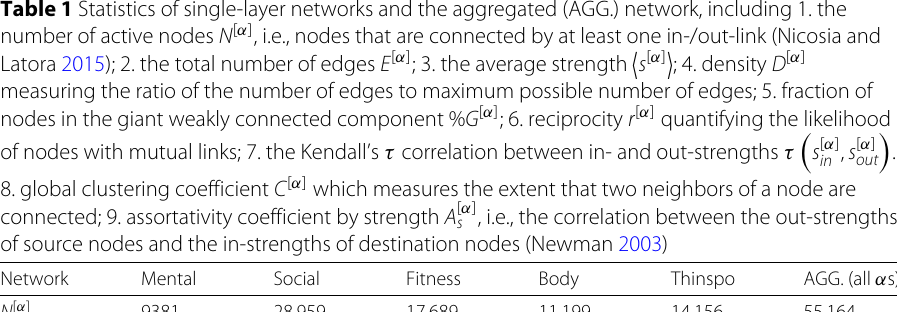
(cid:5) (cid:4) ; 4. density D [ α ] s [ α ]